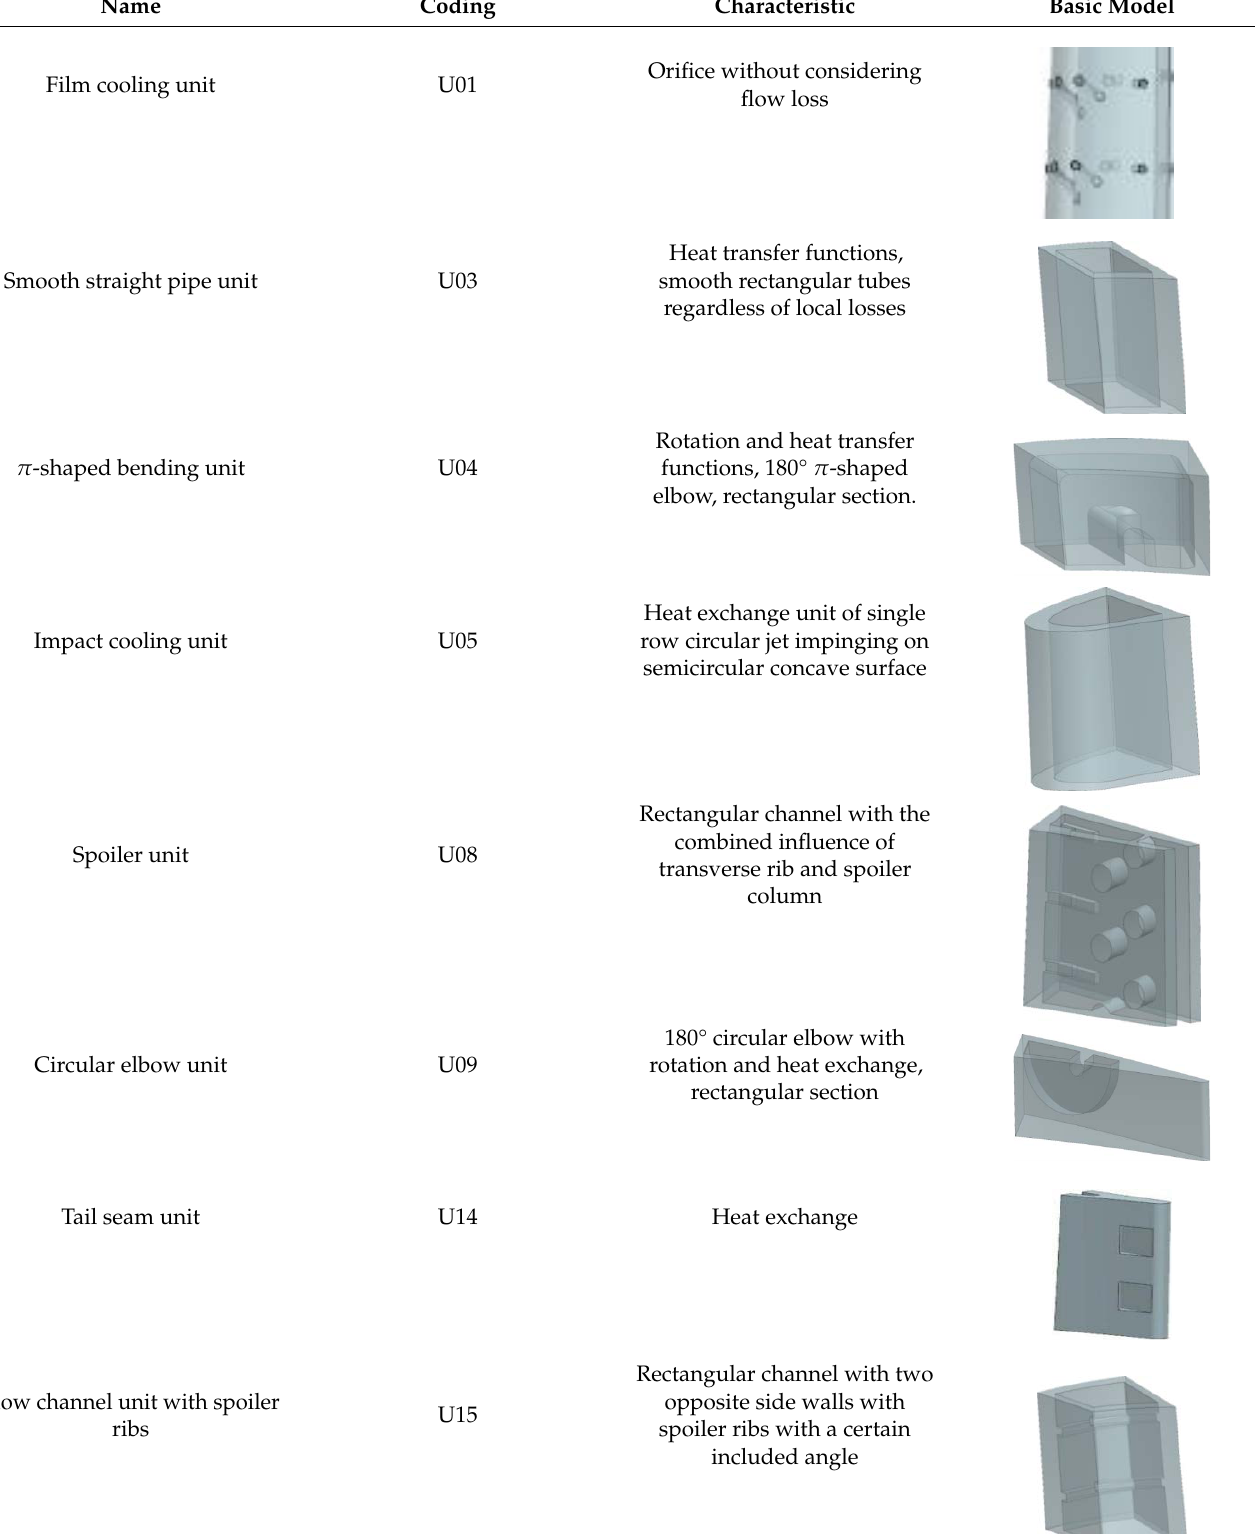
Table 1. Feature library of flowing